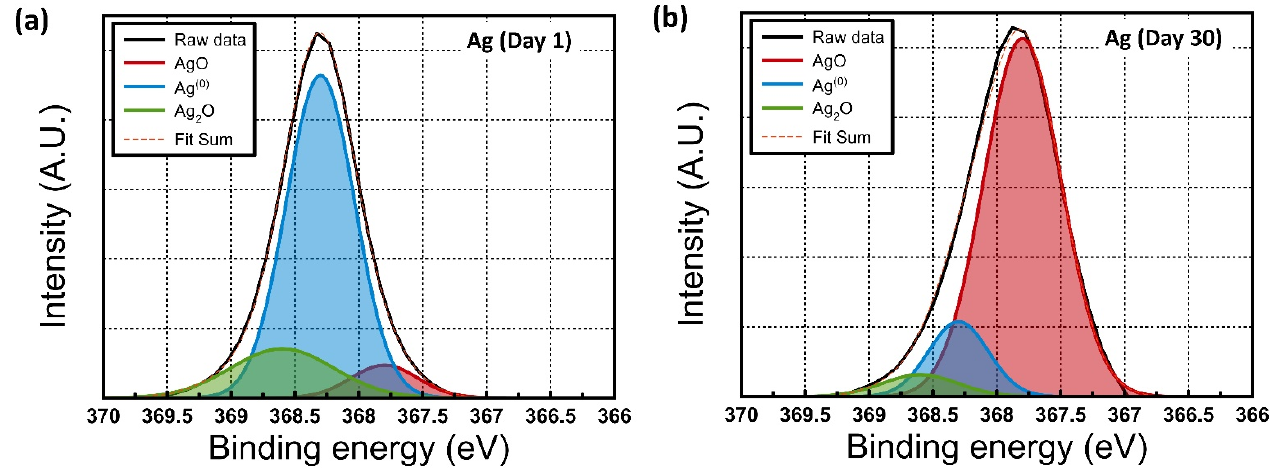
Figure 2. GIXRD spectra of Ag/Y 2 O 3 /ITO/Glass films.